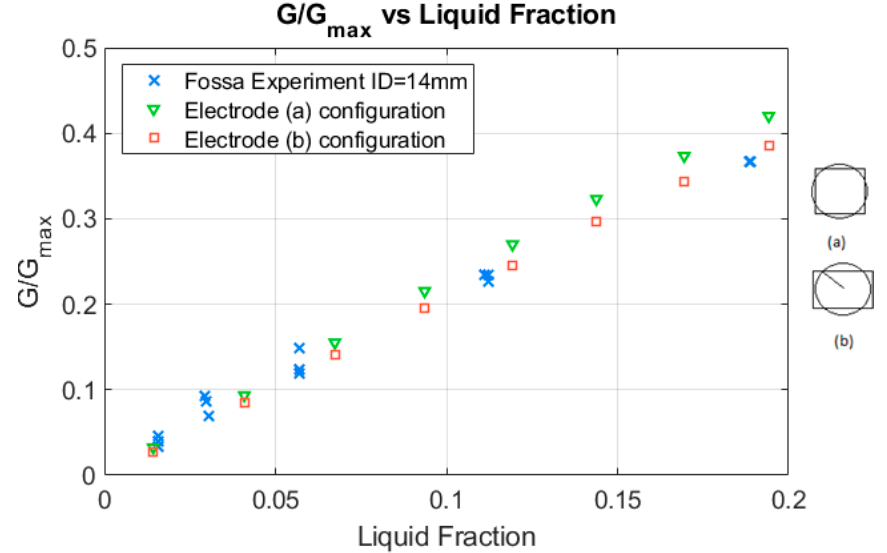
Figure 4. Theoretical versus experimental (blue x) results for the experiments performed by Fossa [8] with a sensor with two-plate electrodes inside a tube with 14mm ID. For the green inverted triangles, the calculations were performed with a square electrode of the same area ( a ). For the red squares, the calculations were performed with the electrode displayed in figure ( b ), of equal surface area than the circular electrode.